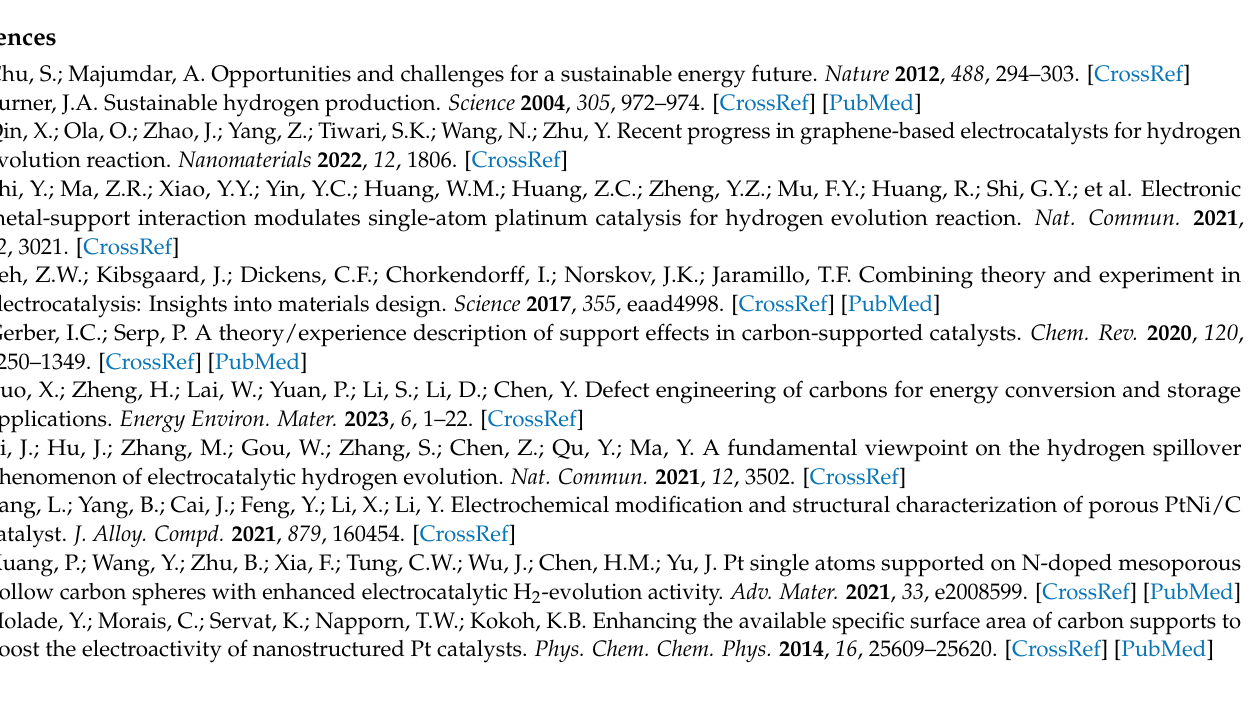
images of Pt/PC (a) and Pt/PC-H-700 (b) catalysts; Figure S9: Tafel slope values of Pt/PC, Pt/PC-H, Pt/PC-H-500, Pt/PC-H-600, Pt/PC-H-700, and Pt/PC-H-800 catalysts; Figure S10: Experimental and simulated Nyquist plots of Pt/PC, Pt/PC-H, Pt/PC-H-500, Pt/PC-H-600, Pt/PC-H-700, and Pt/PC-H-800 catalysts at − 90 mV (inset shows the equivalent circuit model); Figure S11: Current densities of Pt/PC, Pt/PC-H, and Pt/PC-H-700 catalysts in I-t curves at initial, 2 h, 4 h, 6 h, 8 h, and 10 h; Figure S12: LSV curves of Pt/PC (b), Pt/PC-H (c), and Pt/PC-H-700 (d) catalysts before and after 5000 CV cycles; Figure S13: Overpotentials of Pt/PC, Pt/PC-H, and Pt/PC-H-700 catalysts in V-t curves at 1 h, 2 h, 4 h, 6 h, 8 h, and 10 h; Table S1: The content percentages from the decomposed C 1s spectra of Pt/PC, Pt/PC-H, and Pt/PC-H-700 catalysts; Table S2: The content percentages from the decomposed O 1s spectra of Pt/PC, Pt/PC-H, and Pt/PC-H-700 catalysts; Table S3: The content percentages from the decomposed Pt 4f spectra of Pt/PC, Pt/PC-H, and Pt/PC-H-700 catalysts; Table S4: EIS fitting results of Pt/PC, Pt/PC-H, Pt/PC-H-500, Pt/PC-H-600, Pt/PC-H-700, and Pt/PC-H-800